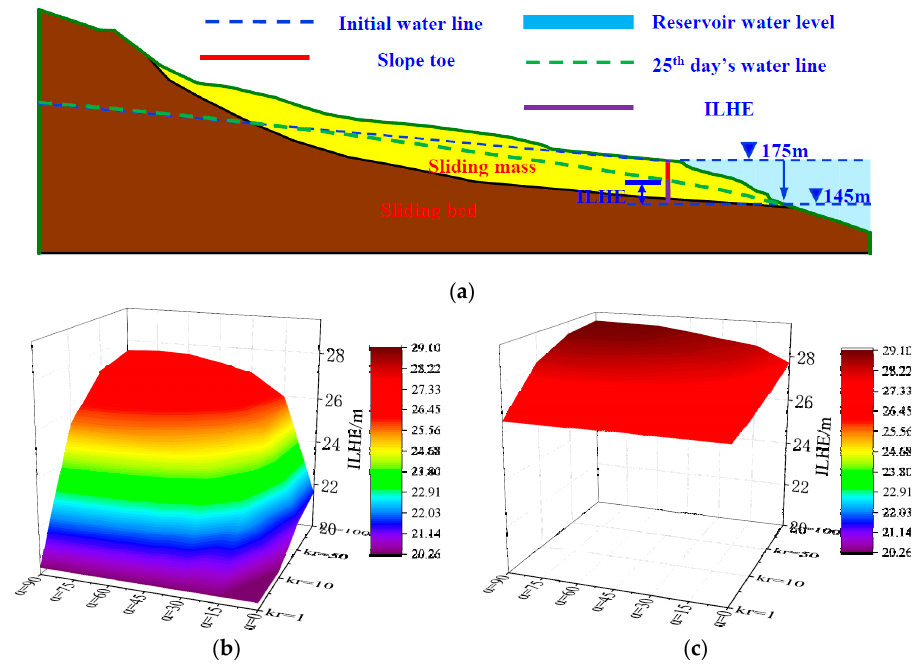
Figure 7. Infiltration line hysteretic elevation (ILHE) of sandy and clay slope under different k r and α values. ( a ) Definition of ILHE . ( b ) Sandy slope . ( c ) Clay slope.